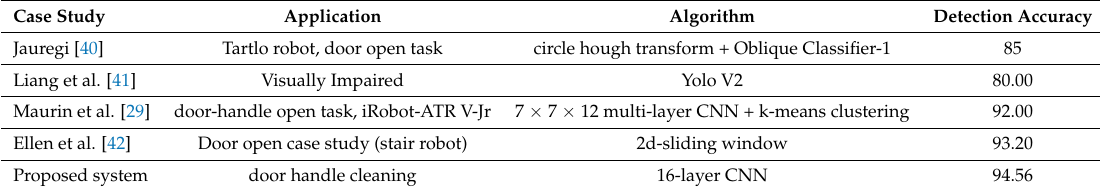
Table 4. Comparison with existing door-handle detection